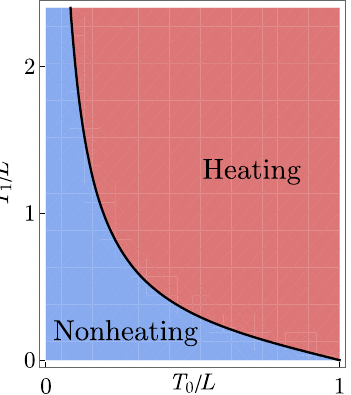
FIG. 16. Phase diagram of the Floquet CFT defined in Sec. II. The red regime is the heating phase, and the blue regime is the nonheating